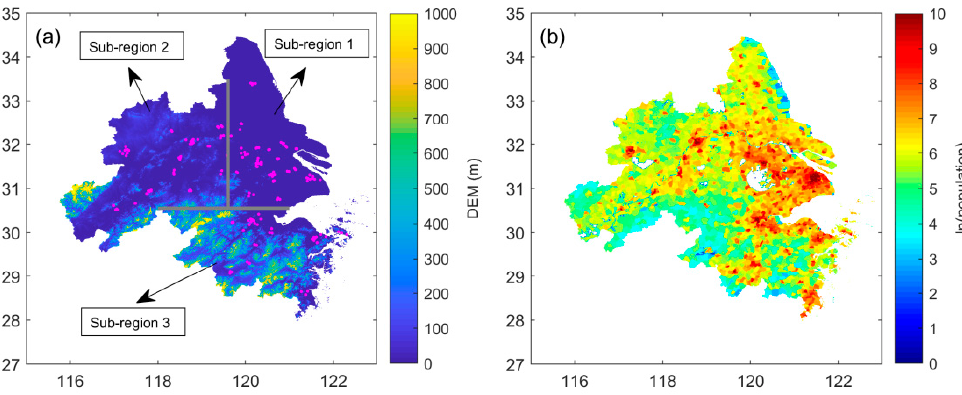
Figure 1. Panel ( a ) presents the locations of PM 2.5 monitoring stations (magenta dots) and DEM at 1 km spatial resolution in the Yangtze River Delta. Panel ( b ) shows the spatial distribution of the natural logarithm of population count in 2020.